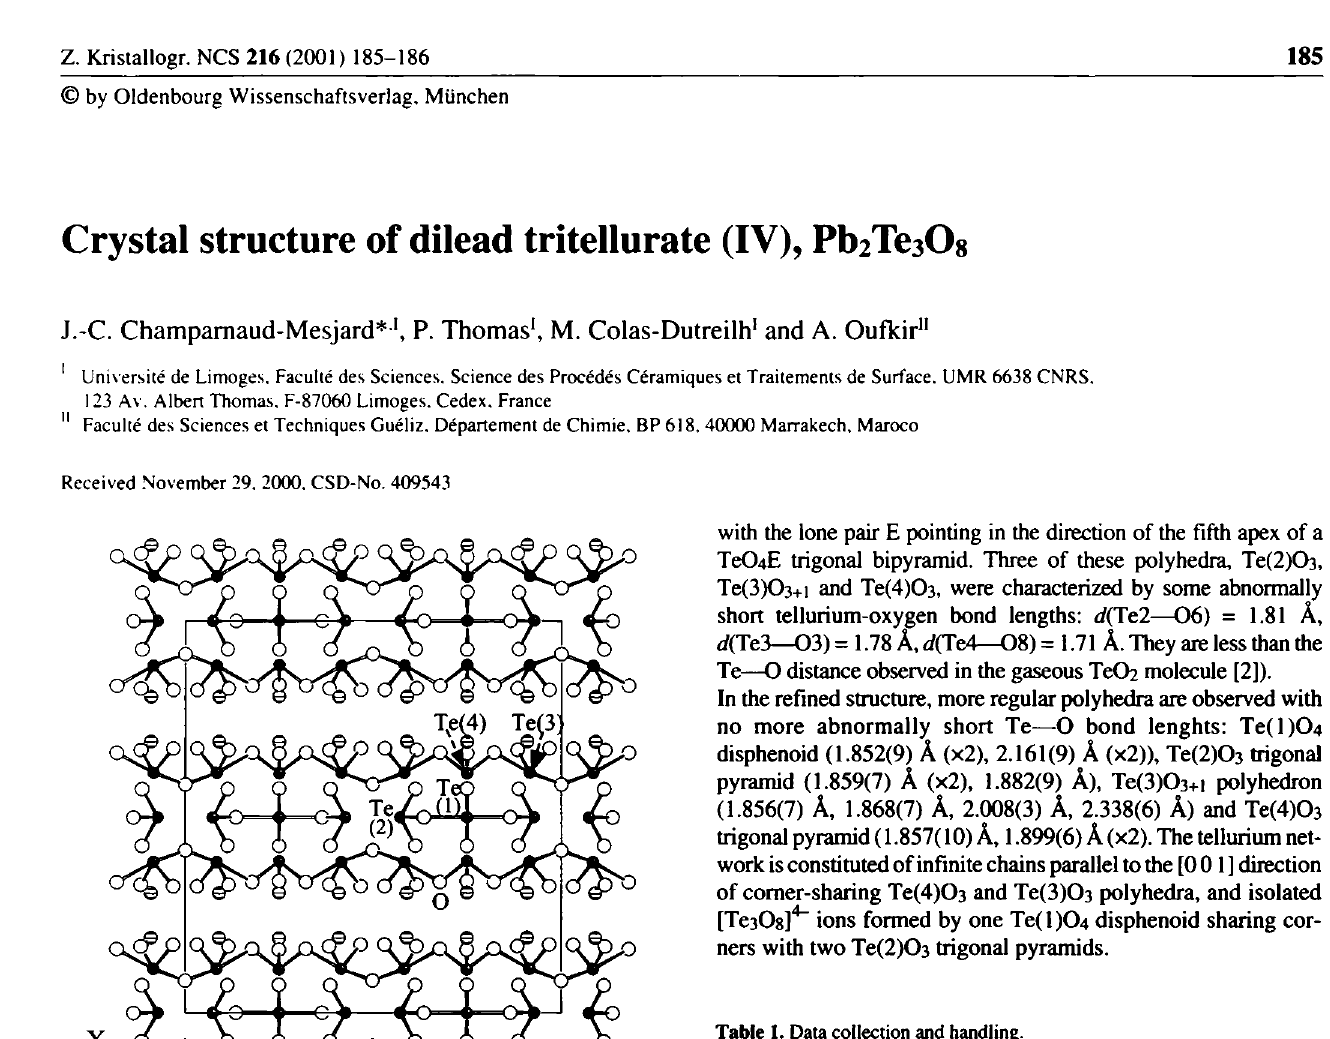
Table 1. Data collection and